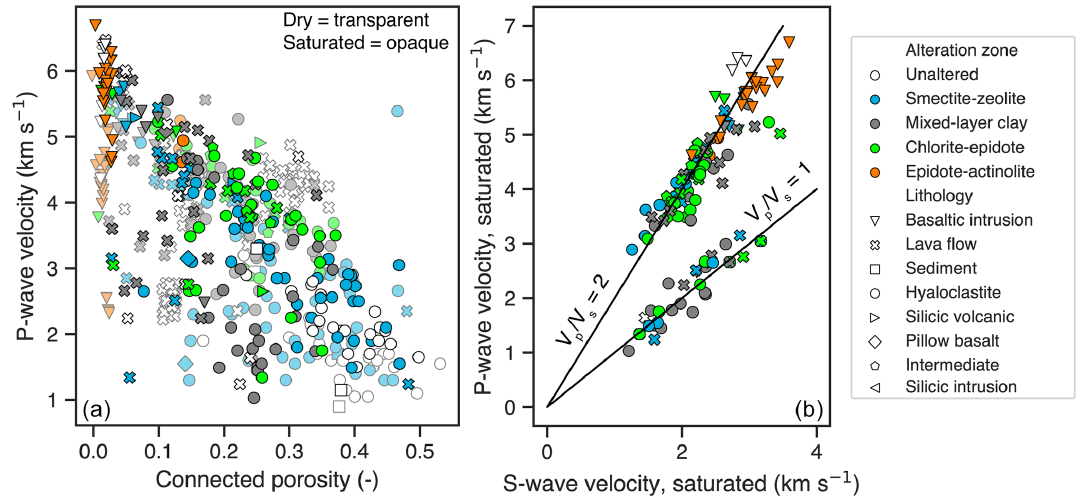
Figure 13. (a) Compressional (P-wave) velocities under dry (transparent symbols) and saturated (opaque symbols) conditions versus con- nected porosity. (b) S-wave velocities versus P-wave velocities under saturated